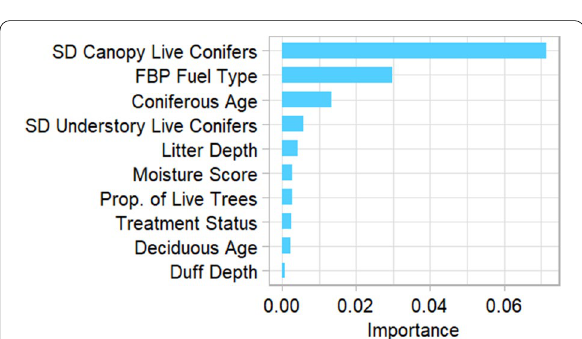
Fig. 8 Conditional permutation importance of independent variables included in the random forest. “SD” and “FBP” represent stand density and the Canadian Fire Behaviour Prediction System